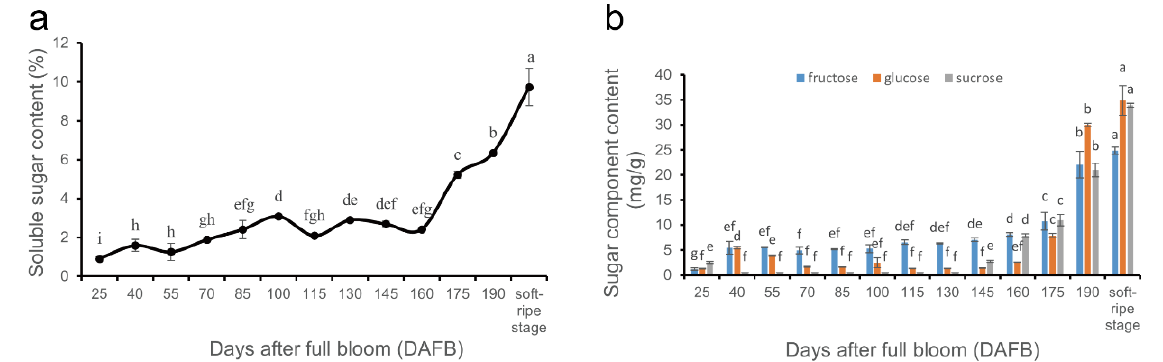
Figure 3. Dynamic changes of soluble sugar content and sugar component content during fruit development of A. eriantha ‘Ganlv 1’. ( a ) Changes of soluble sugar content during fruit development of ‘Ganlv 1’; ( b ) Changes of sugar component content during fruit development of ‘Ganlv 1’.